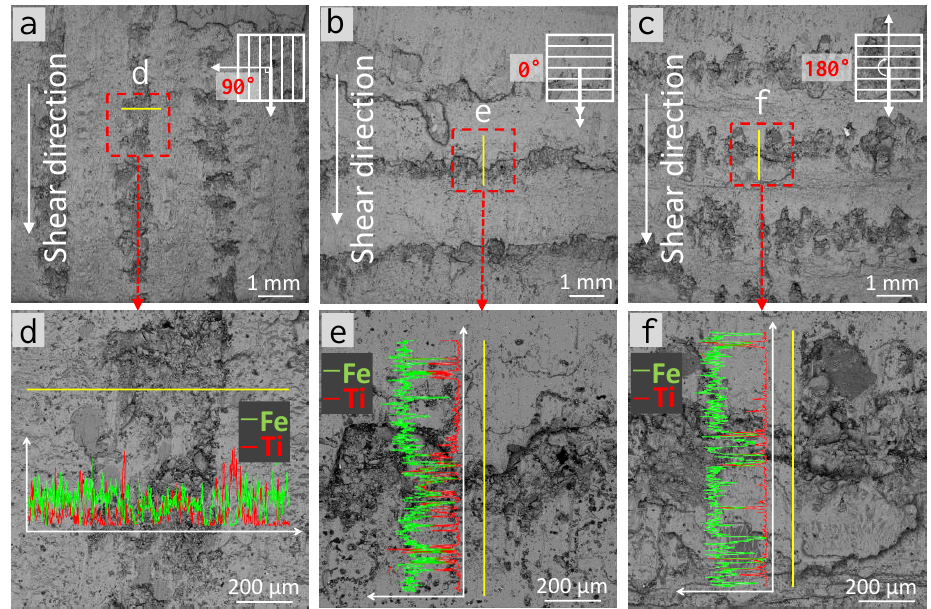
Figure 12. Morphologies and element distributions of the shear fractures: ( a ) 90°; ( b ) 0°; ( c ) 180°; ( d – f ) element distributions of a, b and c.